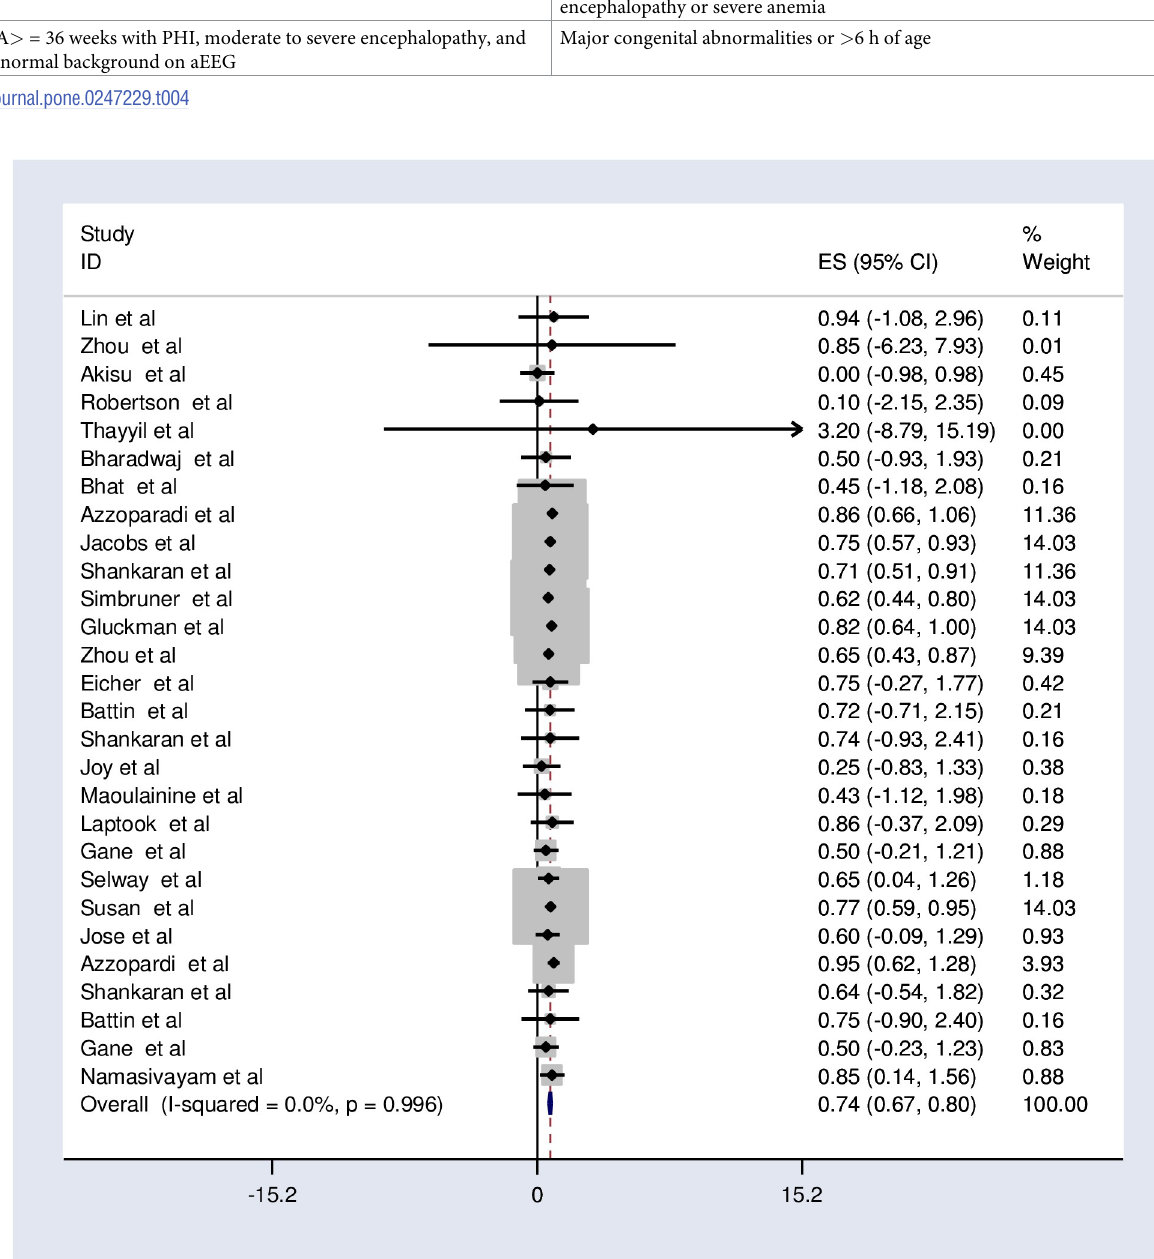
PLOS ONE | https://doi.org/10.1371/journal.pone.0247229 February 25,